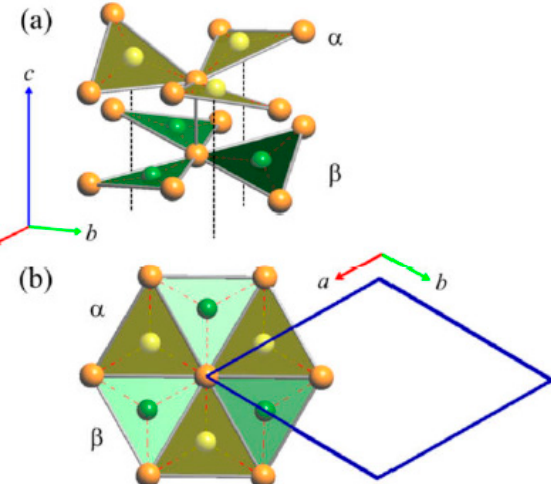
Figure 11. ( a ) Perspective view of the arrangement of the As-centered triangular units in LT—Cu 3 As (only the first two of a total of six different layers are shown); ( b ) top view. Orange and green balls represent Cu and As atoms, respectively.